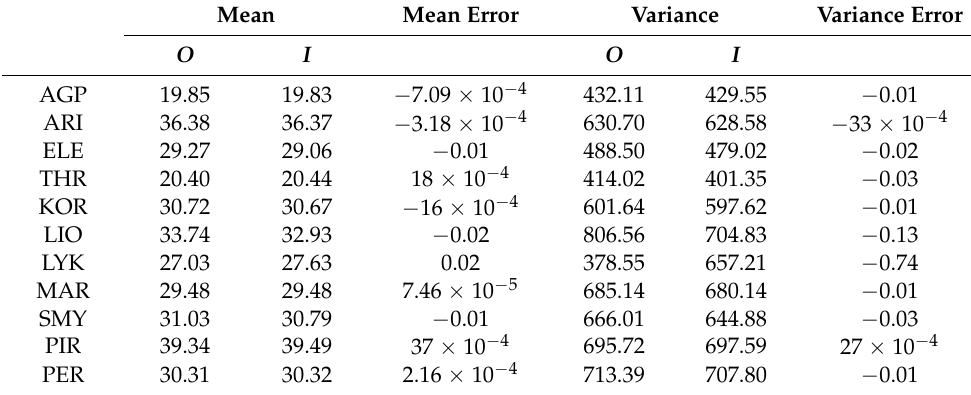
Table 7. Mean and variance values results, for the original ( O ) and the interpolated ( I ) datasets, along with the corresponding error, per monitoring station for PM 10 .